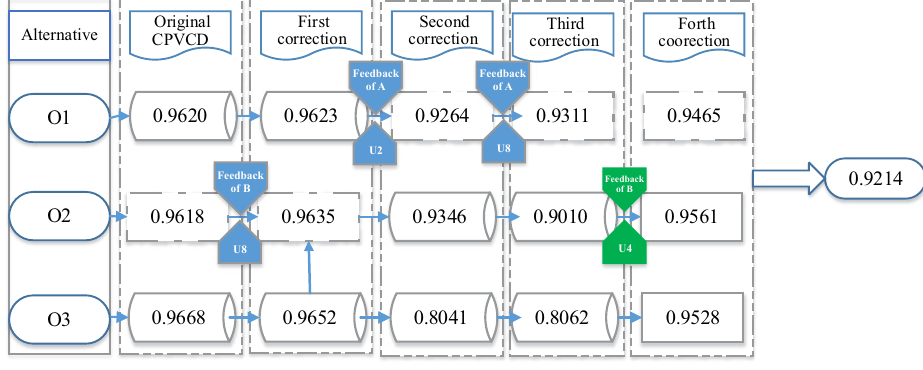
Fig. 3. Feedback correction